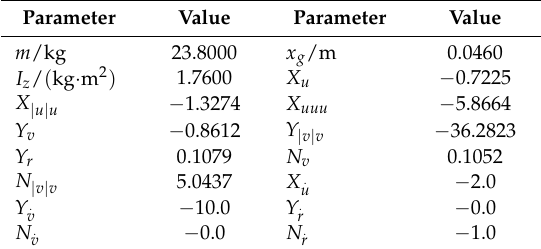
Table 1. Parameters of the